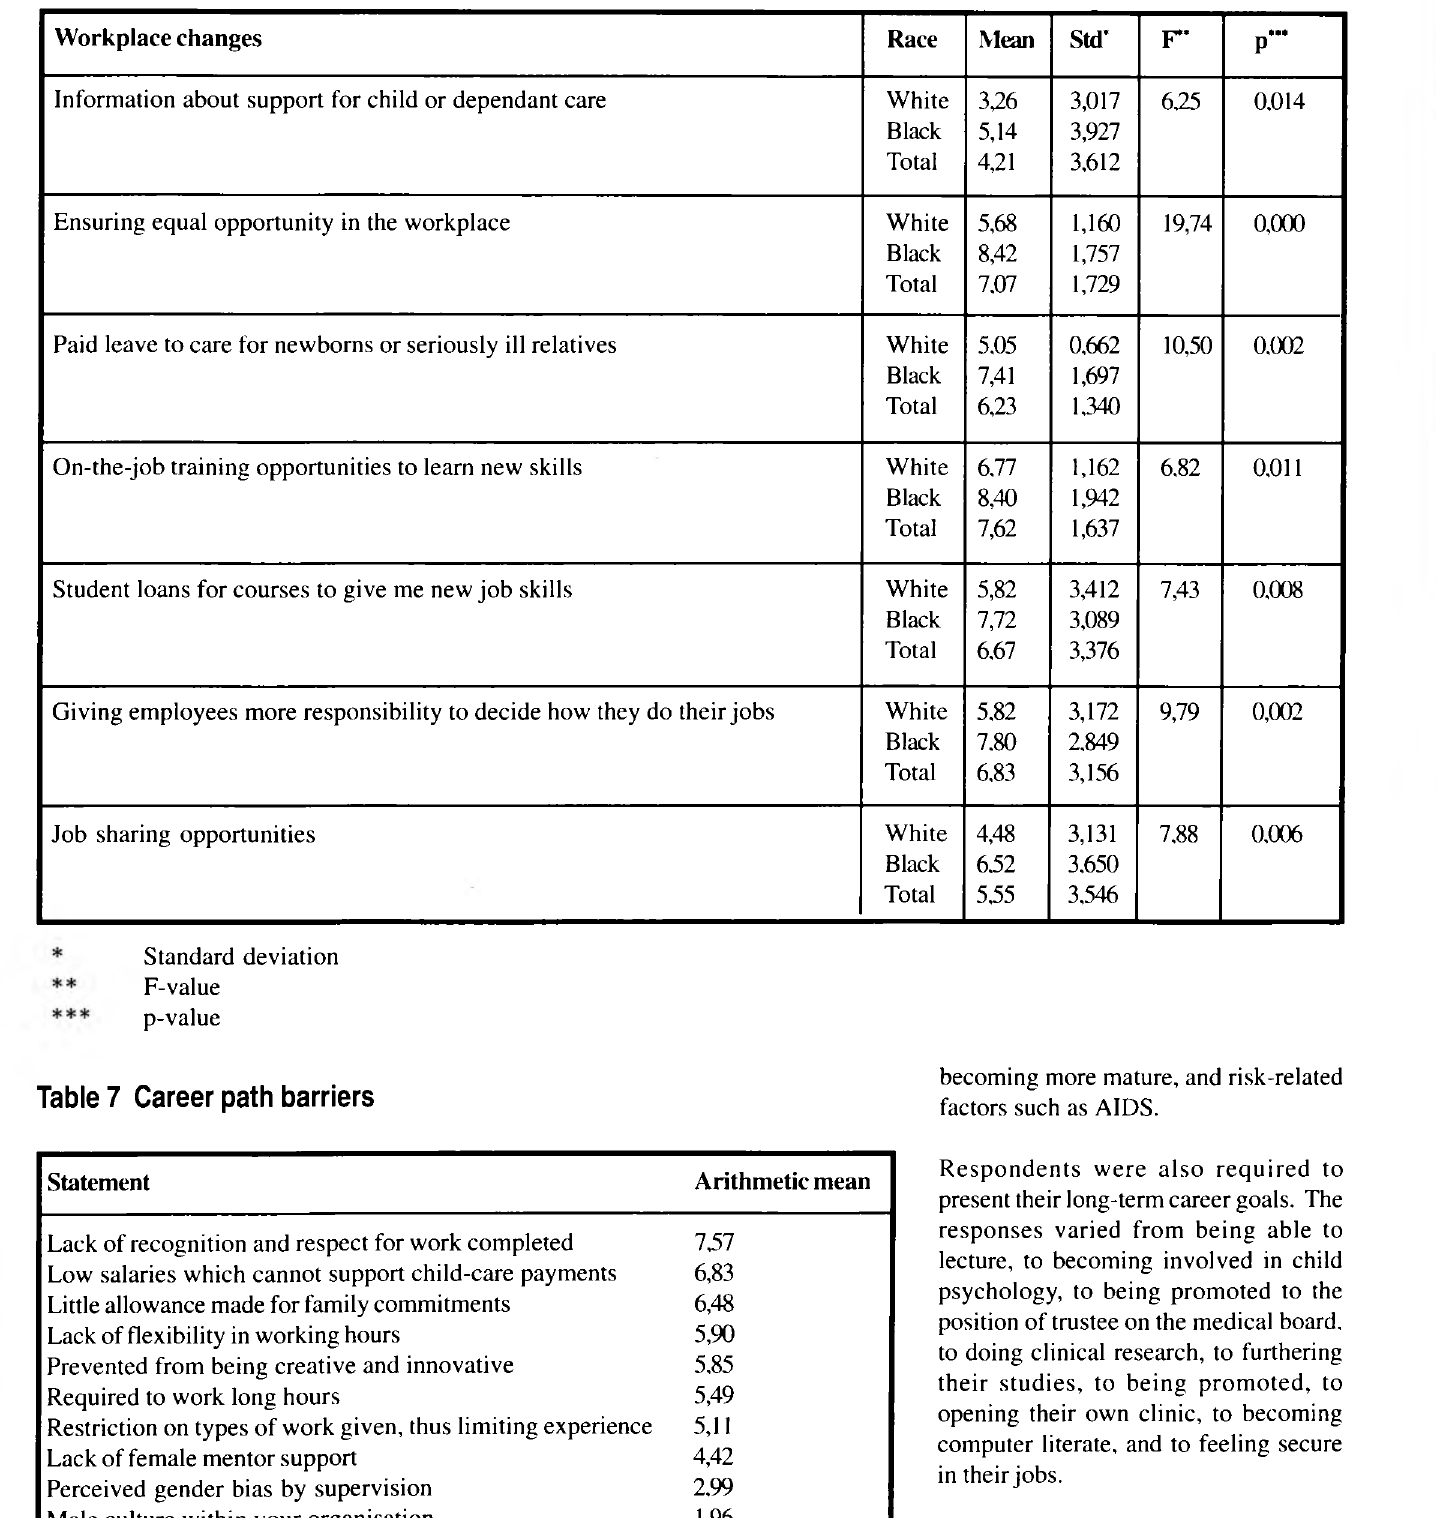
Table 6 How race groups compare with regard to workplace changes W orkplace